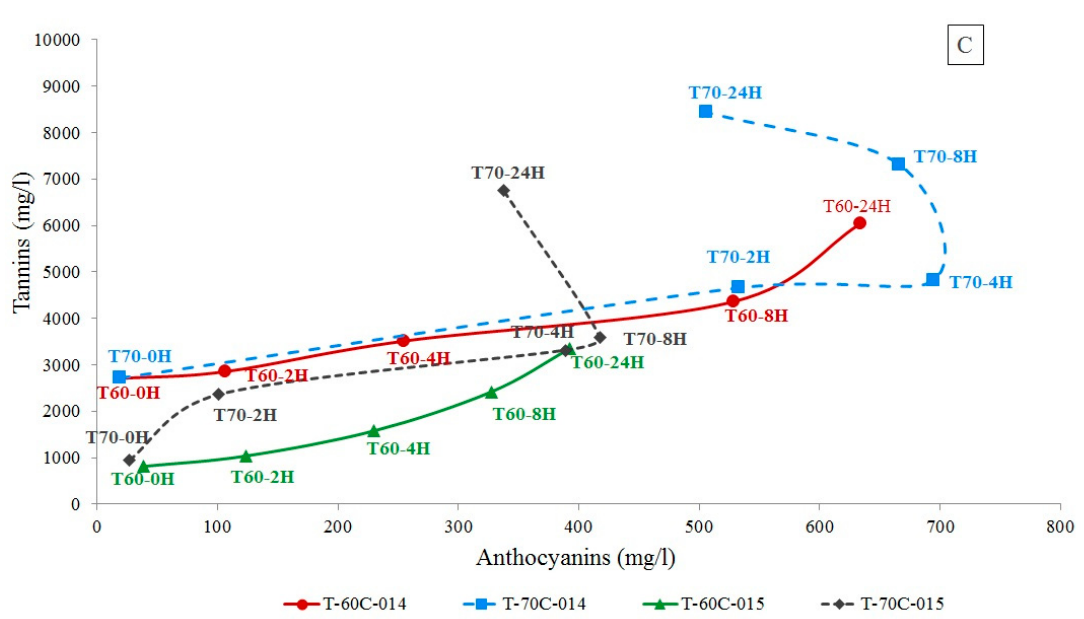
Figure 1. Kinetics of anthocyanins and tannins extraction during the maceration of Syrah grapes from two distinct regions and the two consecutive years (2014 and 2015) in terms of time and temperature ( A ) Chateau Florentine, ( B ) Clos St Thomas 2014, ( C ) Clos St Thomas 2015, T-10C, T-60C, T-70C, T-80C: Maceration temperatures, respectively, at 10, 60, 70 and 80 ◦ C. Example: T-60-4H: Maceration temperature at 60 ◦ C for 4 h.